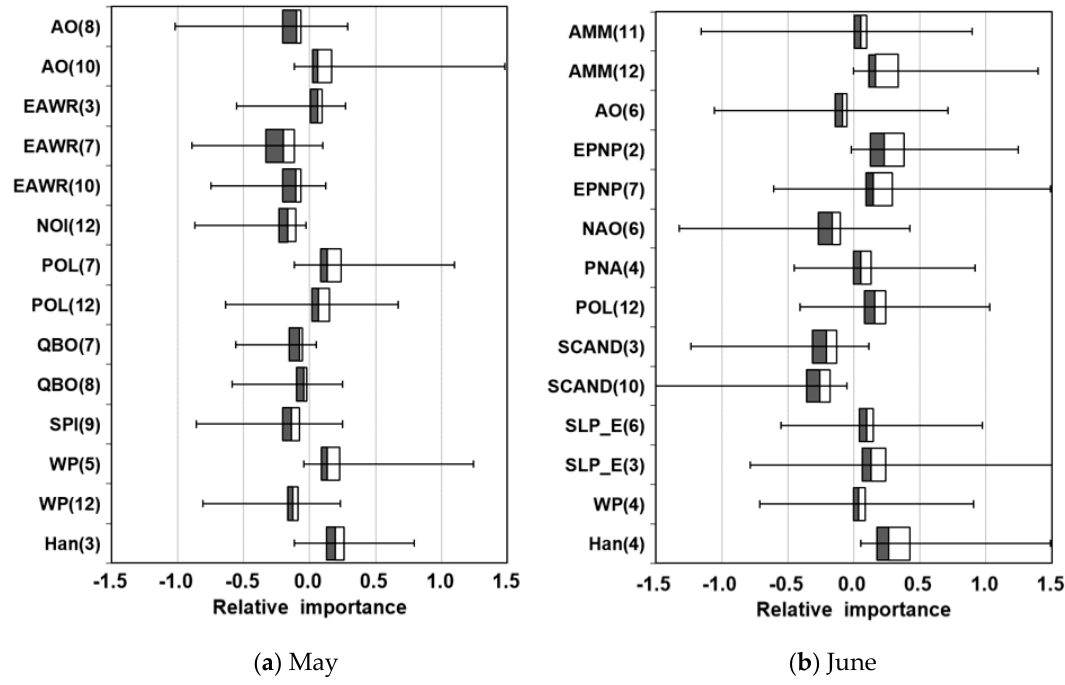
Figure 2. Relative importance of the input variables obtained using the connection weight method for the rainfall in ( a ) May and ( b ) June.